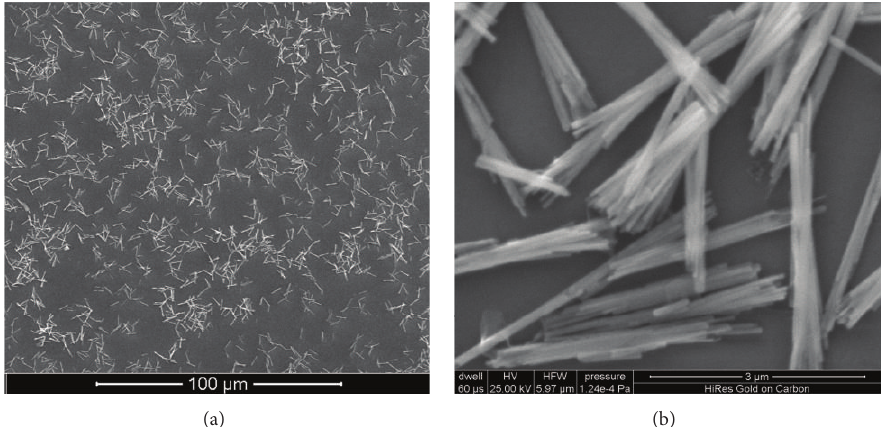
Figure 2: SEM images (a) and (b) of TbPO 4 ⋅ H 2 O nanorods